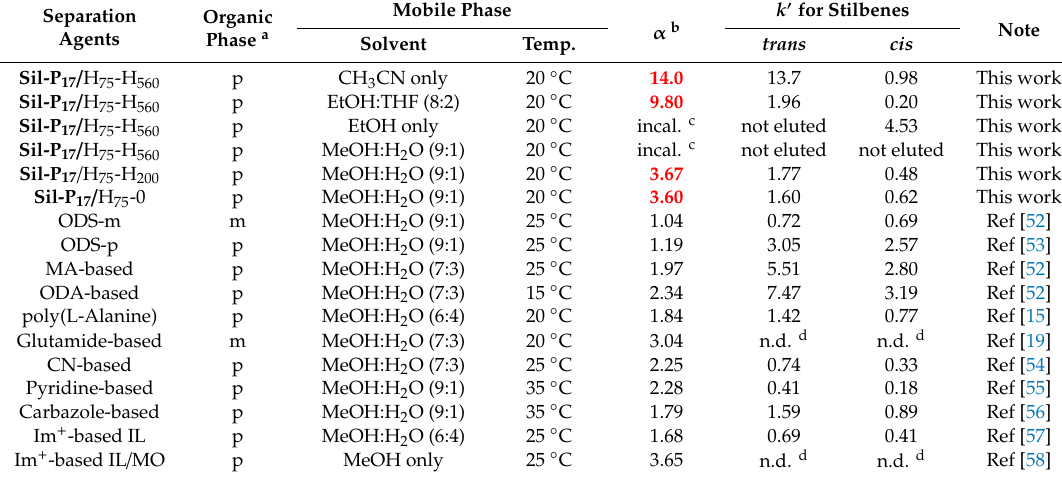
k (cid:48) for Stilbenes α b